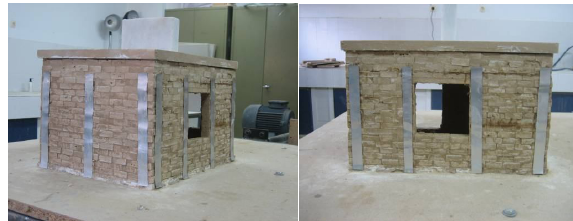
Fig. 16 Steel plate application for model house Fig. 16. Steel plate application for model house.